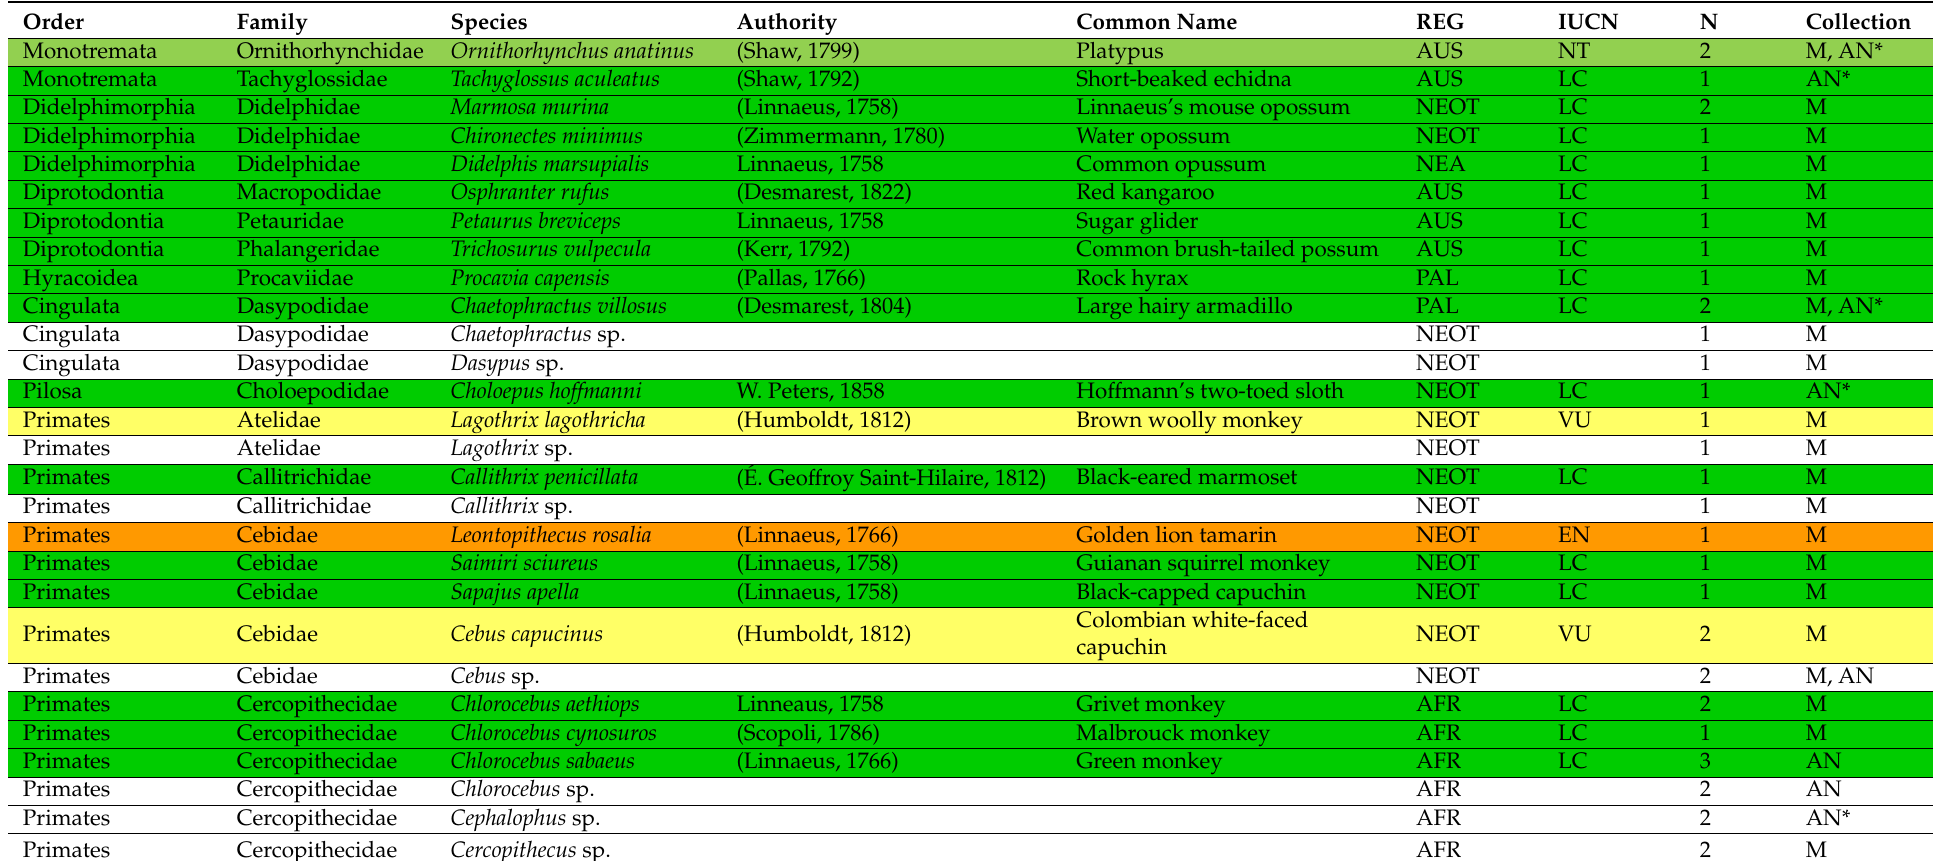
Table 1. List of the species preserved in the Mammal collection at the Museum of Zoology “P. Doderlein”, University of Palermo, Italy. The specimens are stored in the stuffed and mounted (M), fluid-preserved (ML), and anatomical (AN) collections (AN* when skeletons or skeletal remains are present). REG = biogeographic region of specimen origin (PAL = Palaearctic, AFR = Afrotropical, IND = Indo-Malayan, NEA = Nearctic, NEOT = Neotropical, AUS = Australasian, DOM = domestic taxa), N = number of specimens per taxon, IUCN = Italian, European, or Global Red List category, depending from the specimen origin (LC = least